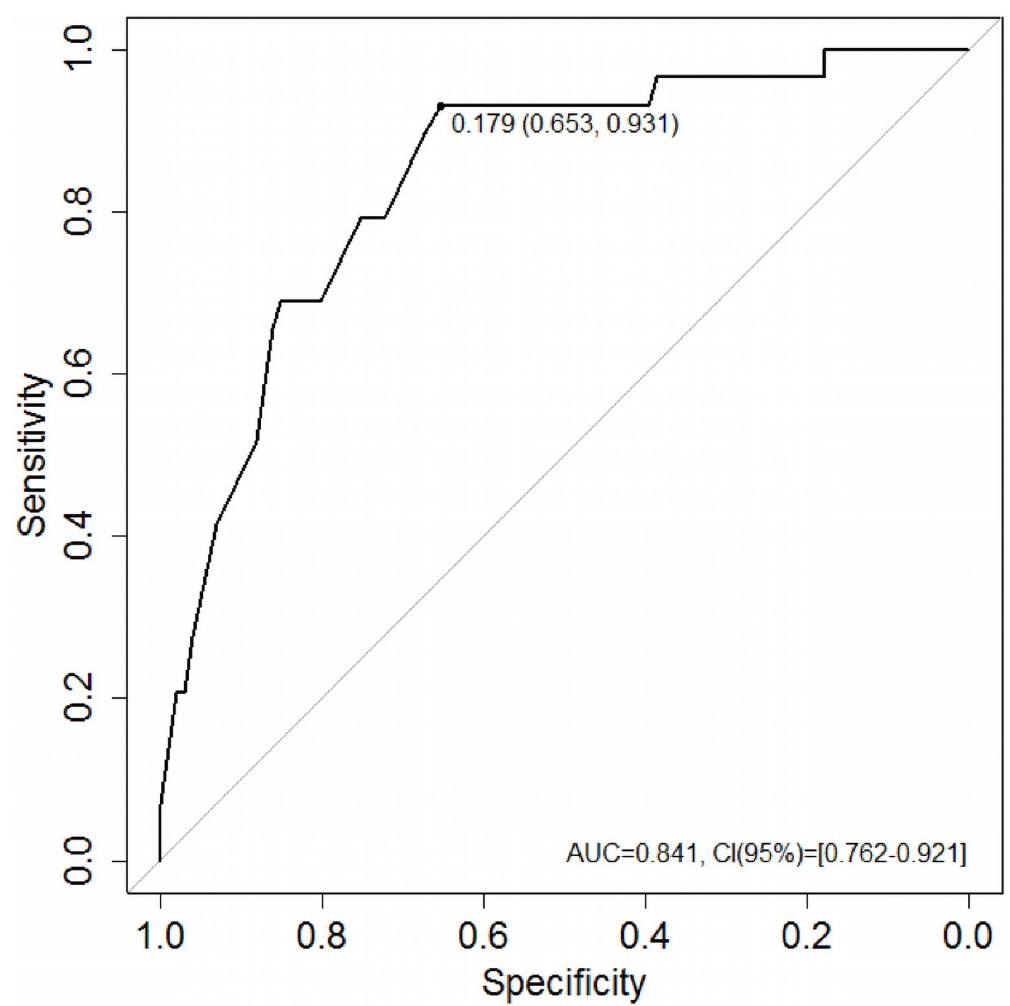
Fig 4. A receiver operating characteristics (ROC) curve obtained via the multiple logistic regression modelling. AUC, area under the curve; CI, confidence interval.